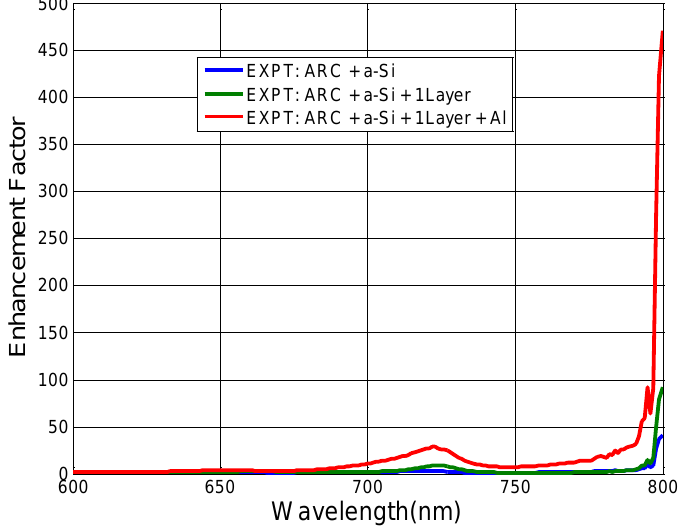
Figure 16. Enhancement factor comparison of the different fabricated structures.